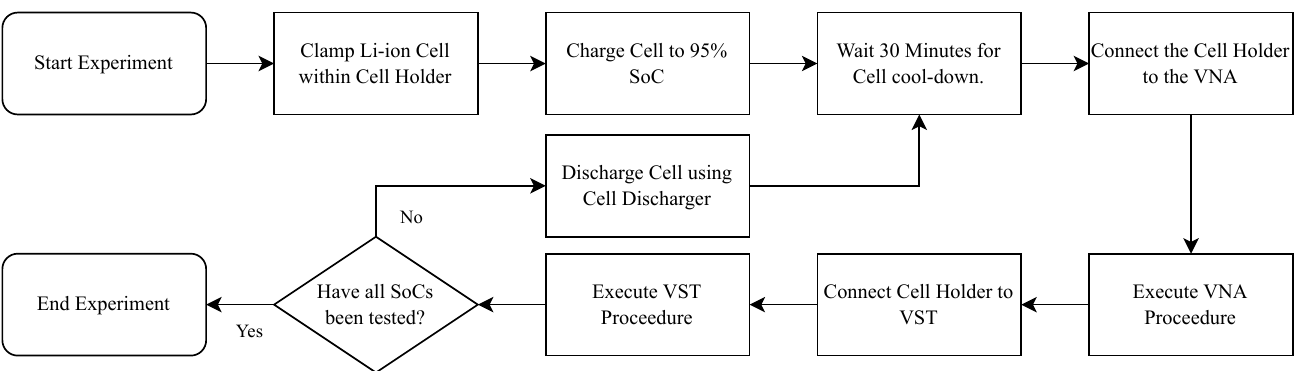
Figure 7. Flowchart of the overall experimental process for obtaining insights into the characteristics of a Li-ion cell at various SoCs and into the associated quality of in situ